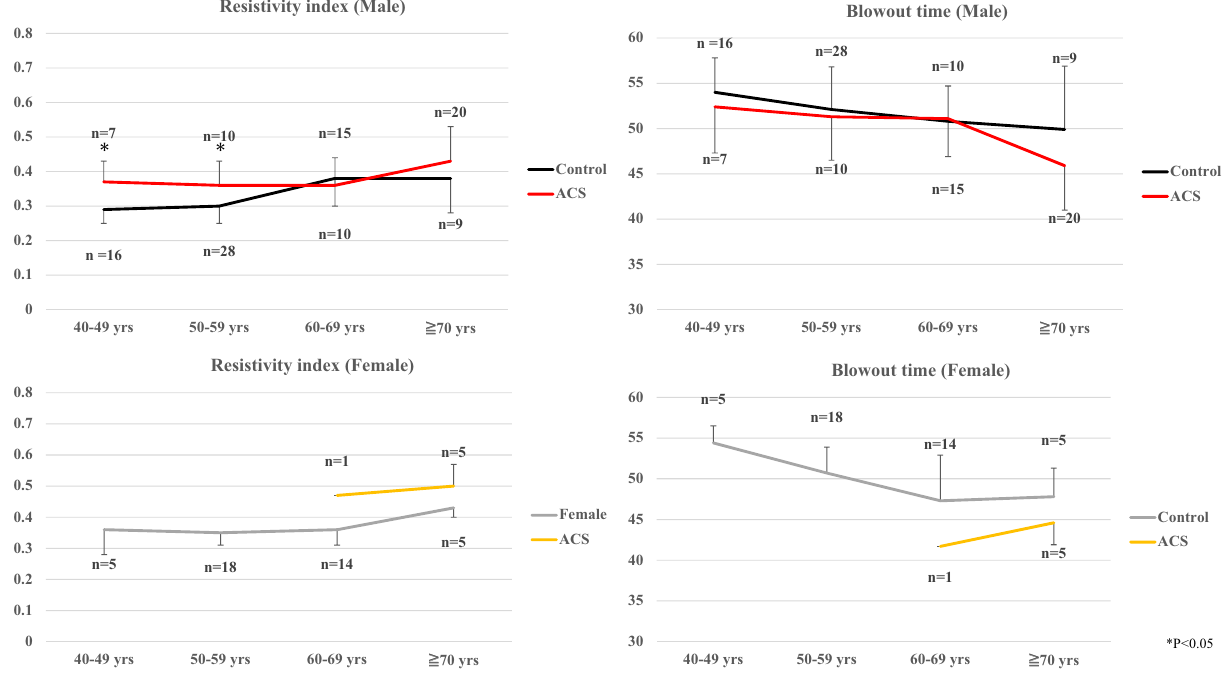
Figure 4. A comparison of the resistivity index (left panels) and blowout time (right panels) between patients with acute coronary syndrome (ACS) and controls in each age category divided by male and female sex. The mean ocular RI was higher in the male ACS patients than in the control male subjects in the 40 to 49 years (0.37 ± 0.02 vs. 0.29 ± 0.01, P < 0.001) and 50 to 59 years (0.36 ± 0.02 vs. 0.30 ± 0.01, P = 0.01) , while BOT was not different among age categories regardless of sex.